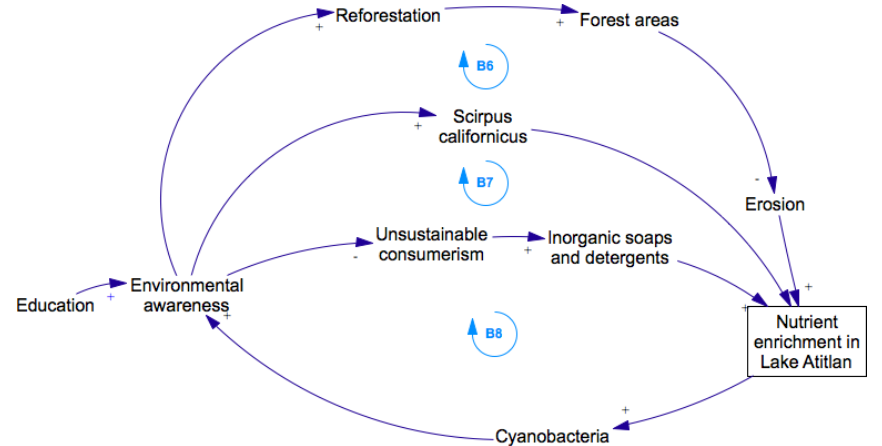
Figure 10. Environmental awareness